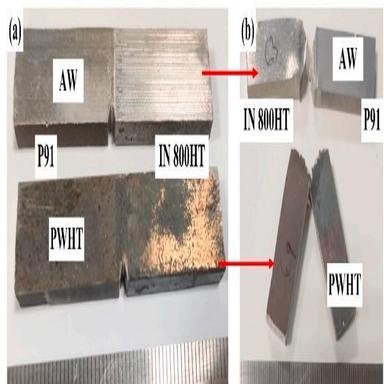
V-notched Charpy impact toughness specimens (a) before testing; (b) after testing.